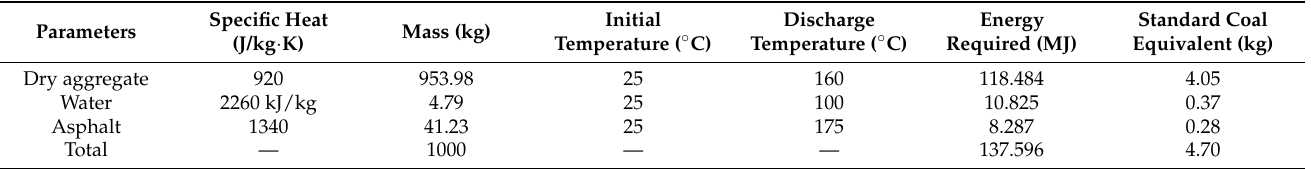
Table 9. Energy consumption used to heat 1 ton of